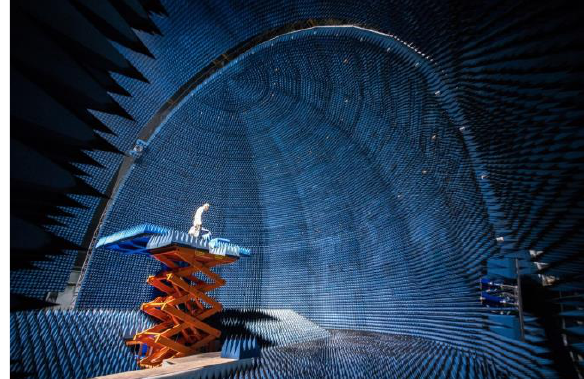
Figure 2. Interior view of the experimental platform [33].